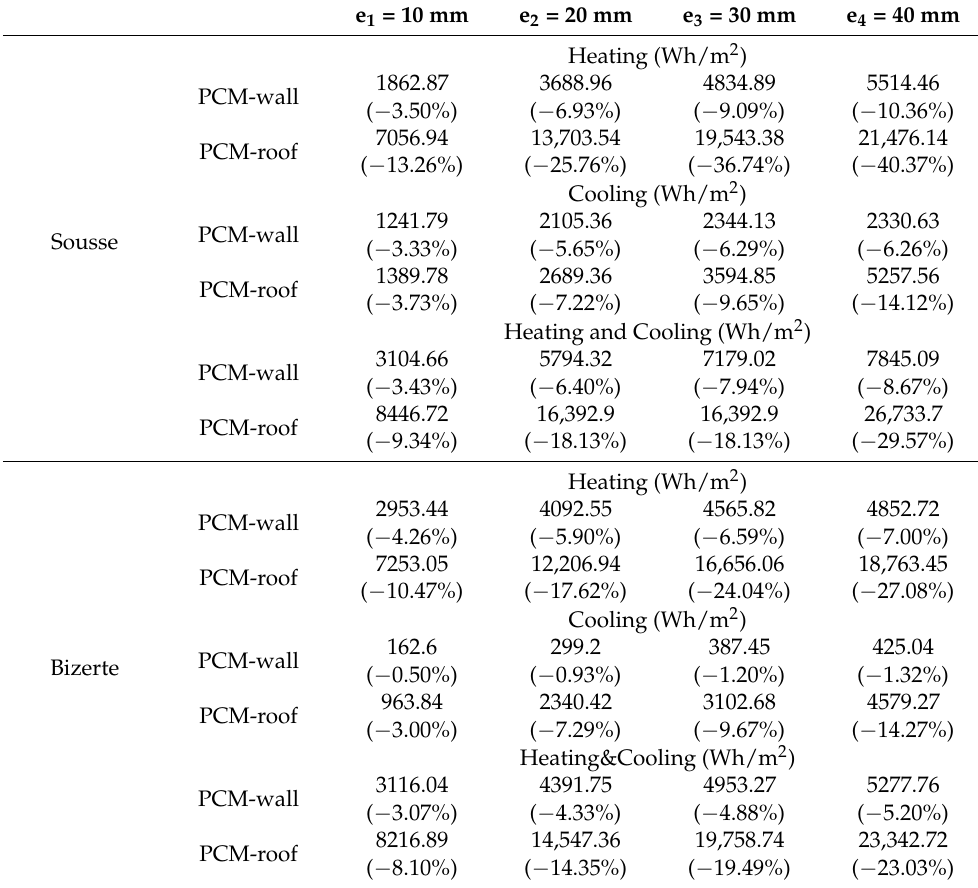
Table 4. Annual heating and cooling energy saving per 1 m 2 of three types of building envelopes and for five PCM layer